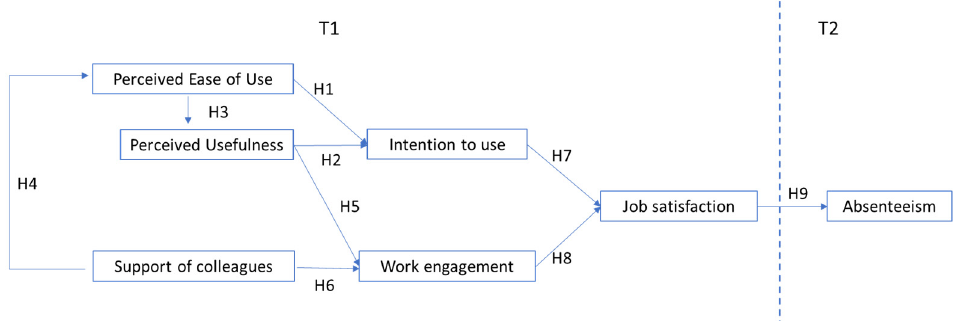
Figure 1. The hypothesized